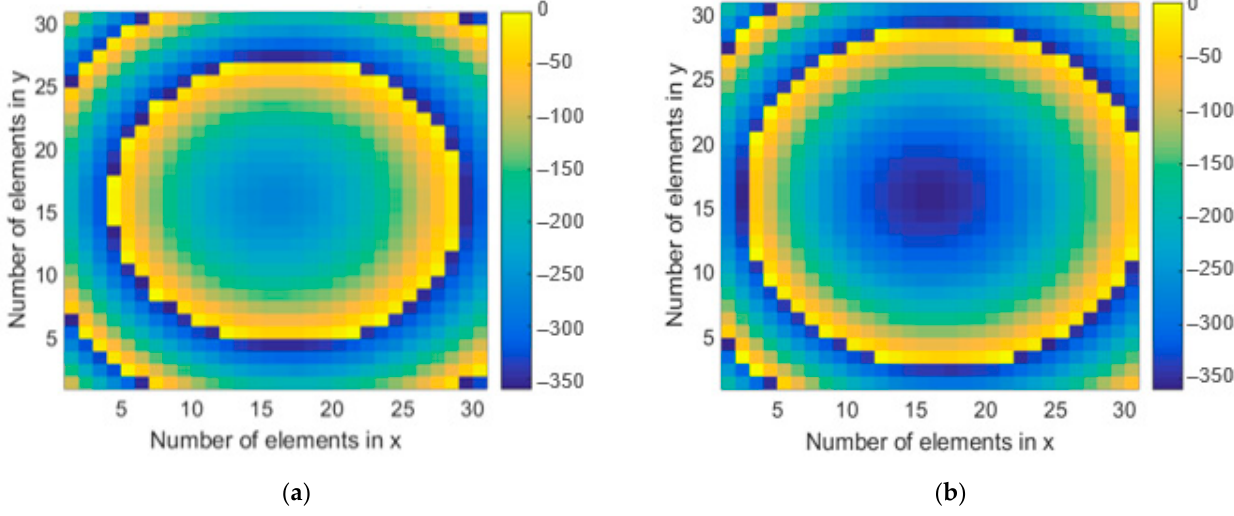
Figure 3. Phase shifts (in degrees) that must be introduced by the reflectarray elements in the ( a ) x component and ( b ) y component of the incident field to produce a dual-CP beam at 19.7 GHz.